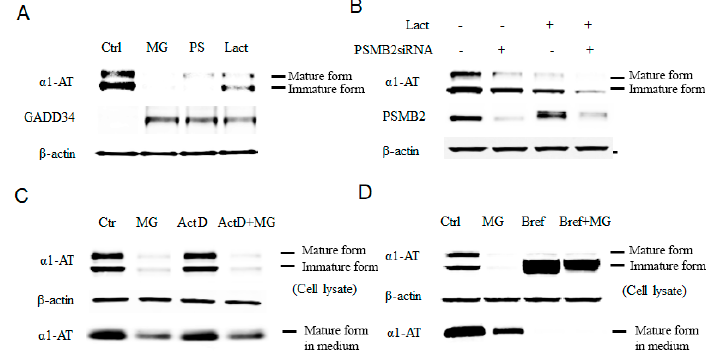
Figure 1. Inhibition of proteasome causes reduction of the alpha 1 antitrypsin ( α 1AT) level in human hepatocyte cell line. ( A ) C3A cells were incubated for 4 h in the presence or absence (control) of proteasome inhibitors MG132 (10 µ m), PS-341 (10 µ m), or lactacystin (10 µ m). ( B ) Knock down of the 20 s proteasome subunit β 2 was performed in with siRNA for 72 h and cells were then treated with or without lactacystin (10 µ m) for 4 h. ( C ) C3A cell were treated for 4 h with actinomycin D (0.1 µ g / mL), MG132 (10 µ m) or both actinomycin and MG132. ( D ) C3A cells were incubated for 4 h in the presence or absence of MG132 (10 µ m), Brefeldin A (2 µ g / mL) or both Brefeldin A and MG132. Cell lysates were analyzed by western blot analysis using antibodies to α 1AT, GADD34 or β